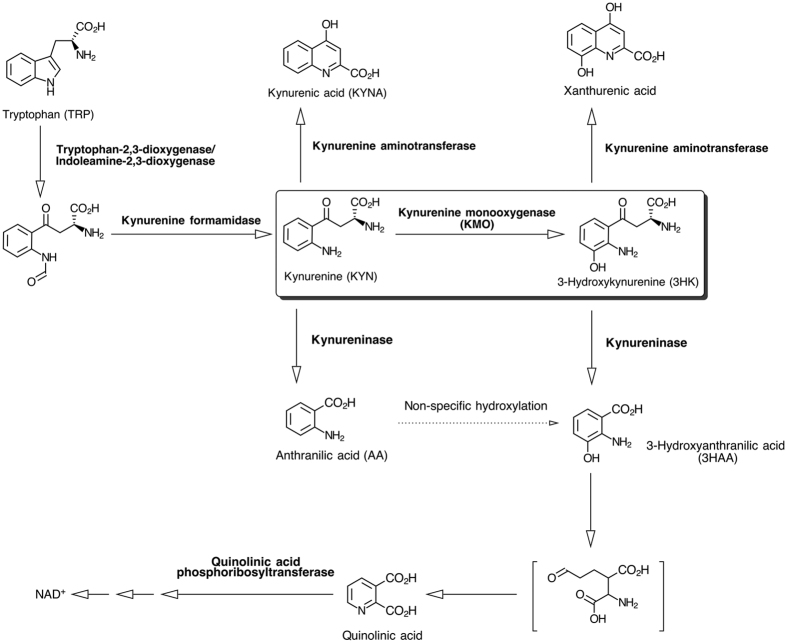
The kynurenine pathway of tryptophan metabolism.The key step of kynurenine conversion to 3-hydroxykynurenine via the action of the gate-keeper enzyme kynurenine 3-monooxygenase (KMO), is highlighted.